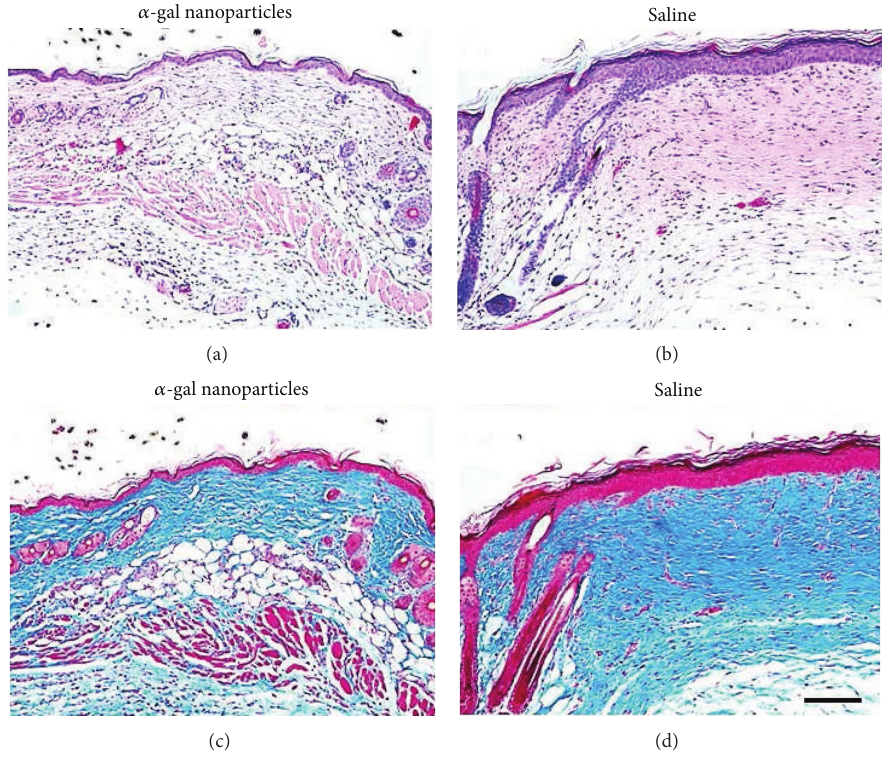
Figure 5: Prevention of scar formation in GT-KO mouse wounds treated with 𝛼 -gal nanoparticles. Representative wound treated for 28 days with 𝛼 -gal nanoparticles and stained with H&E (a) and with trichrome (c). Representative saline treated wound after 28 days, stained with H&E (b) and with trichrome (d). Collagen is stained blue by trichrome. 𝛼 -gal nanoparticles treated wounds (a, c) display restoration of normal skin structure, including thin epidermis, loose connective tissue in the dermis and appearance of skin appendages including hair, sebaceous glands, fat and muscle cells in the hypodermis. Saline treated wounds (b, d) undergo fibrosis to form a scar characterized by dense connective tissue as a result of extensive collagen secretion by multiple infiltrating fibroblasts, no skin appendages and hyperplastic epidermis. The hair shafts in the left are of the uninjured area bordering the wound. Scale bar in (d) is 100 𝜇 m ( × 100). Specimens are representative of 5 mice per group. Modified from